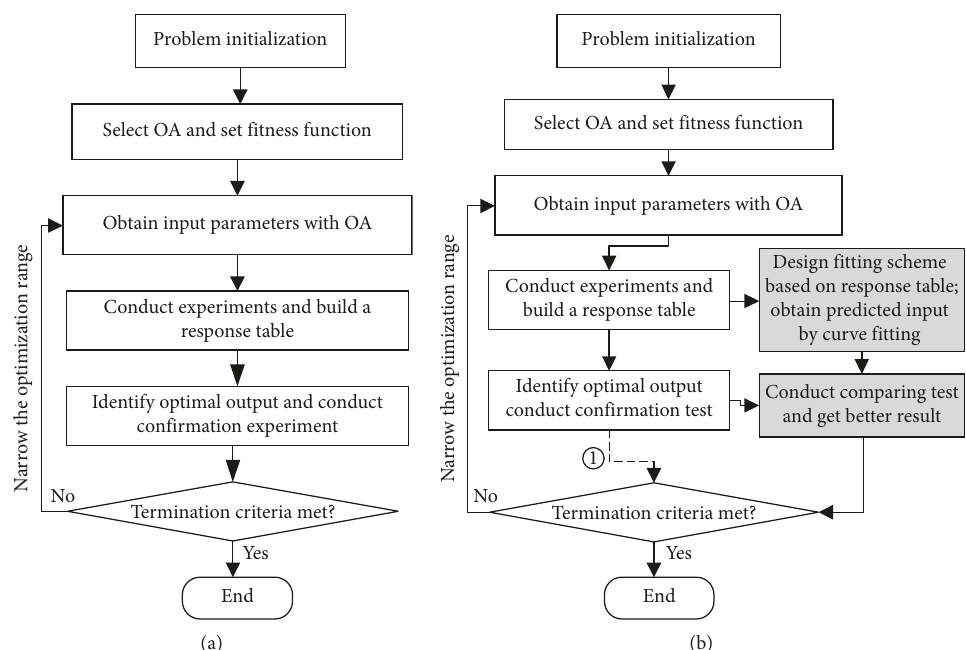
Figure 1: Main flow chart of the two Taguchi methods. (a) The normal one. (b) The proposed